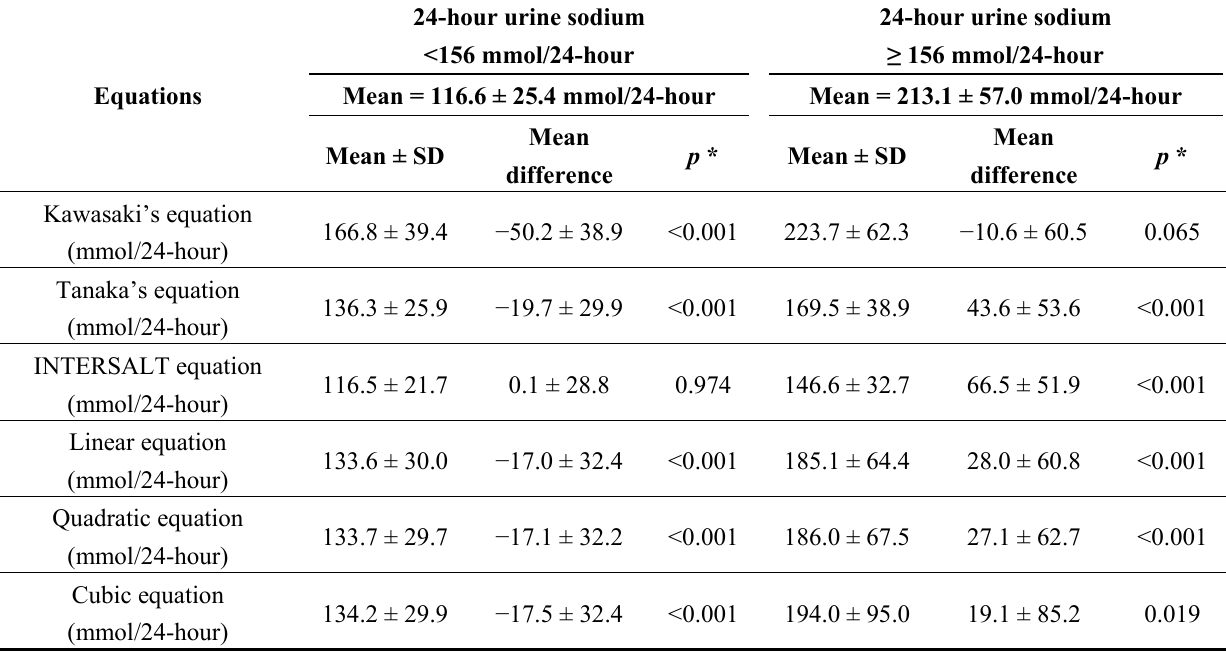
Table 3. Difference of estimated and measured 24-hour urine sodium excretion by levels of measured 24-hour urine sodium